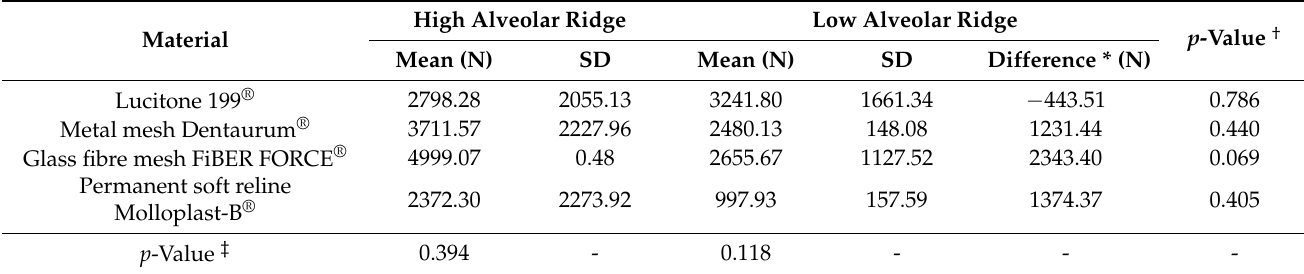
Table 3. Average maximum masticatory strength of each type of material for low- and high-alveo- lar-ridge groups.